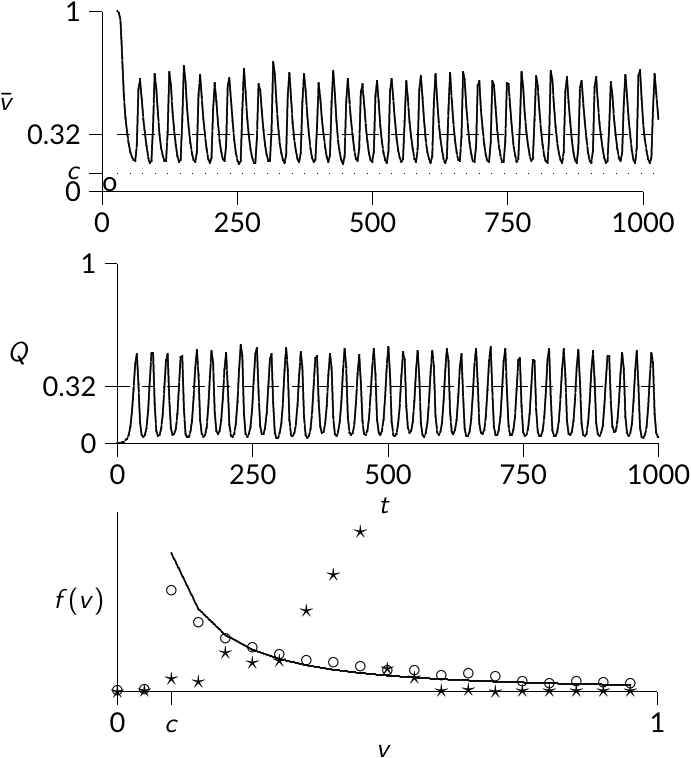
Figure 4 – Unstable dynamics in a simulation with pure strategies, assuming c = 0.1 , K = 2 , and 2 K c = 0.4 . In this simulation 2 K c < 1 , so the NE does not resist invasion by pure strategies. In each generation there were 3333 groups of size 3. The dashed lines show ¯ v = 0.32 (upper panel) and Q = 0.32 (middle panel), the values predicted by the NE (equations 13 and 12). In the lower panel, the stars and circles show empirical frequency distributions of the strategy variable v . The distribution shown with stars was calculated from the simulation’s final generation, while that shown with circles aggregates over a large number of generations—all generations since the first in which ¯ v fell to the value predicted by equation 13. The solid line shows the Nash